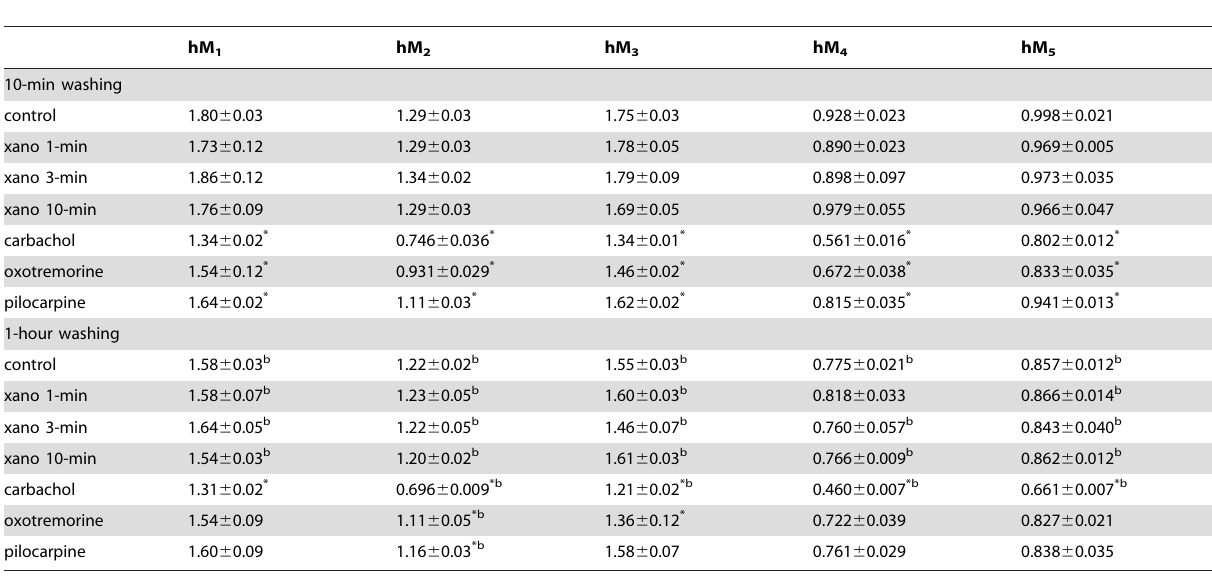
Table 2. Maximum binding capacities (B MAX ) of [ 3 H]NMS binding to the membranes of the cells treated with xanomeline, carbachol, oxotremorine or pilocarpine are expressed as pmol of binding sites per mg of membrane